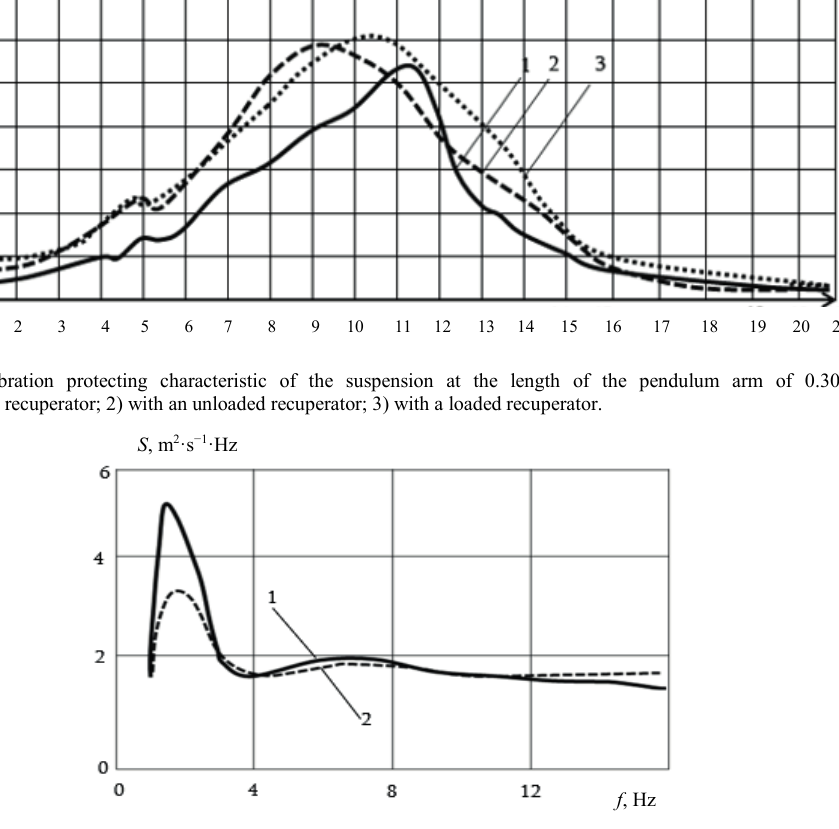
Fig. 16. Spectral density of vertical accelerations on the rear suspension in the range of Z s = 0–20 Hz at normal profile of the cobblestone with a speed V = 4.2 m · sec –1 : 1) suspension without a recuperator; 2) suspension with a